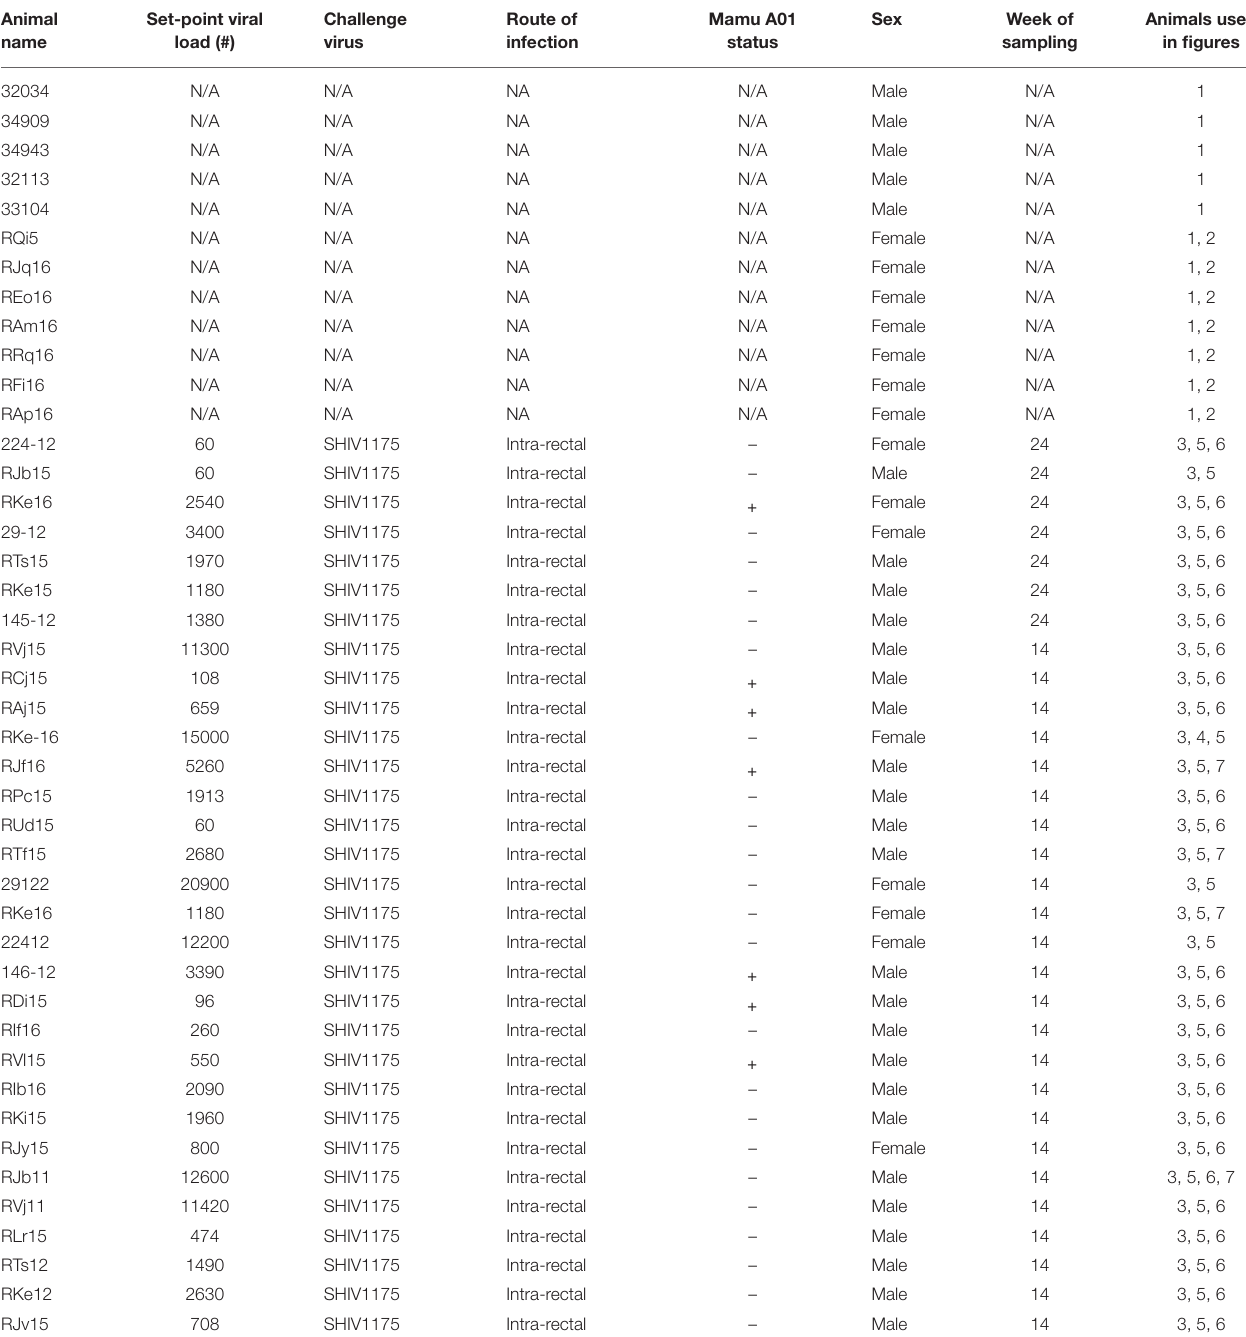
TABLE 1 | Cohort of SHIV infected rhesus macaques used for the